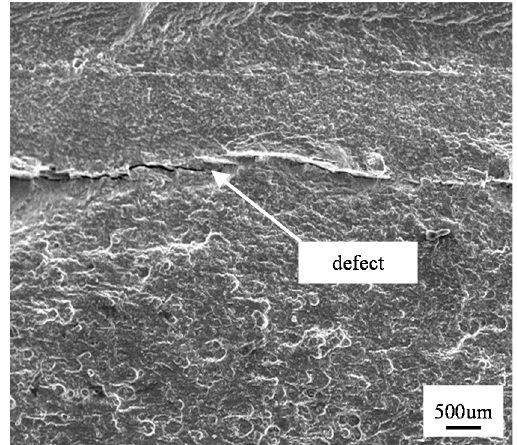
Figure 7. Defect inside the repairing zone when ν = 110 mm/min and ω = 1100 r/min.